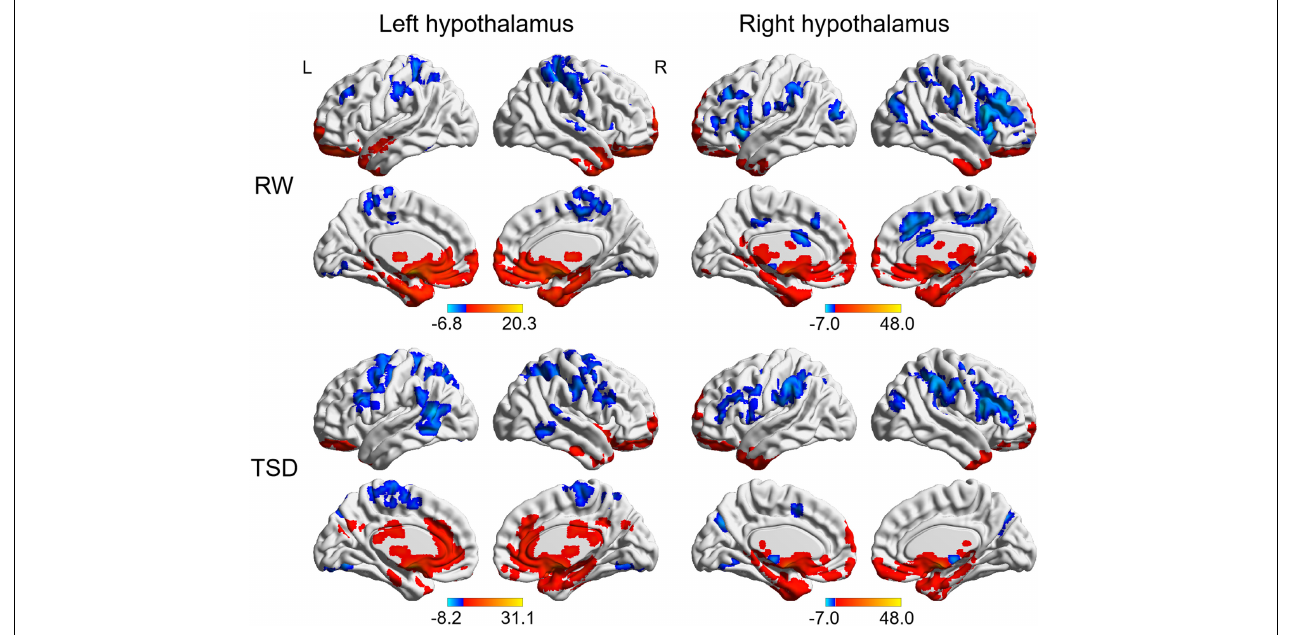
FIGURE 2 | Whole-brain functional connectivity patterns of hypothalamus in RW and TSD states (AlphaSim corrected, P < 0.01). Colored bars indicate t- values of one-sample t -test within RW and TSD groups. RW, rested wakefulness; TSD, total sleep deprivation.